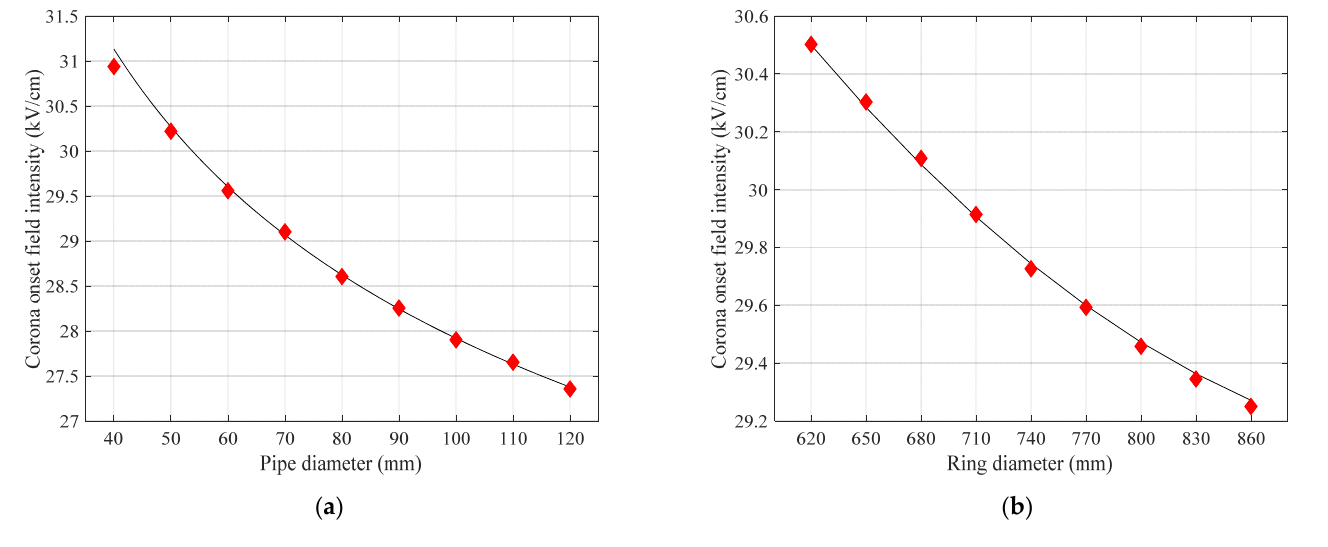
Figure 14. The COI calculated by the prediction formula in this paper is compared with the test results ( a ) Comparison of test result and fitting results on the variation of the COI changing with pipe diameter; ( b ) Comparison of test result and fitting results on the variation of the COI changing with ring diameter.